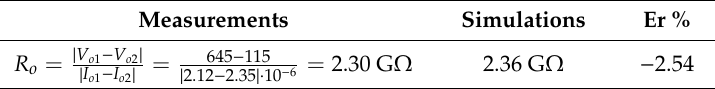
Figure 13. Transient response and steady state of the accumulated voltage in the capacitor ( C _load = 1 µ F) of the harvesting circuit when the PZT piezoelectric material is utilized in the Test Bench: ( a ) Output voltage recorded by virtual instrument (VI) when using a set of resistors of equivalent R _load1 = 300 M Ω ; ( b ) output voltage when R _load2 = 50 MΩ. Table 4. Empirical verification of the methodology. PZT material.